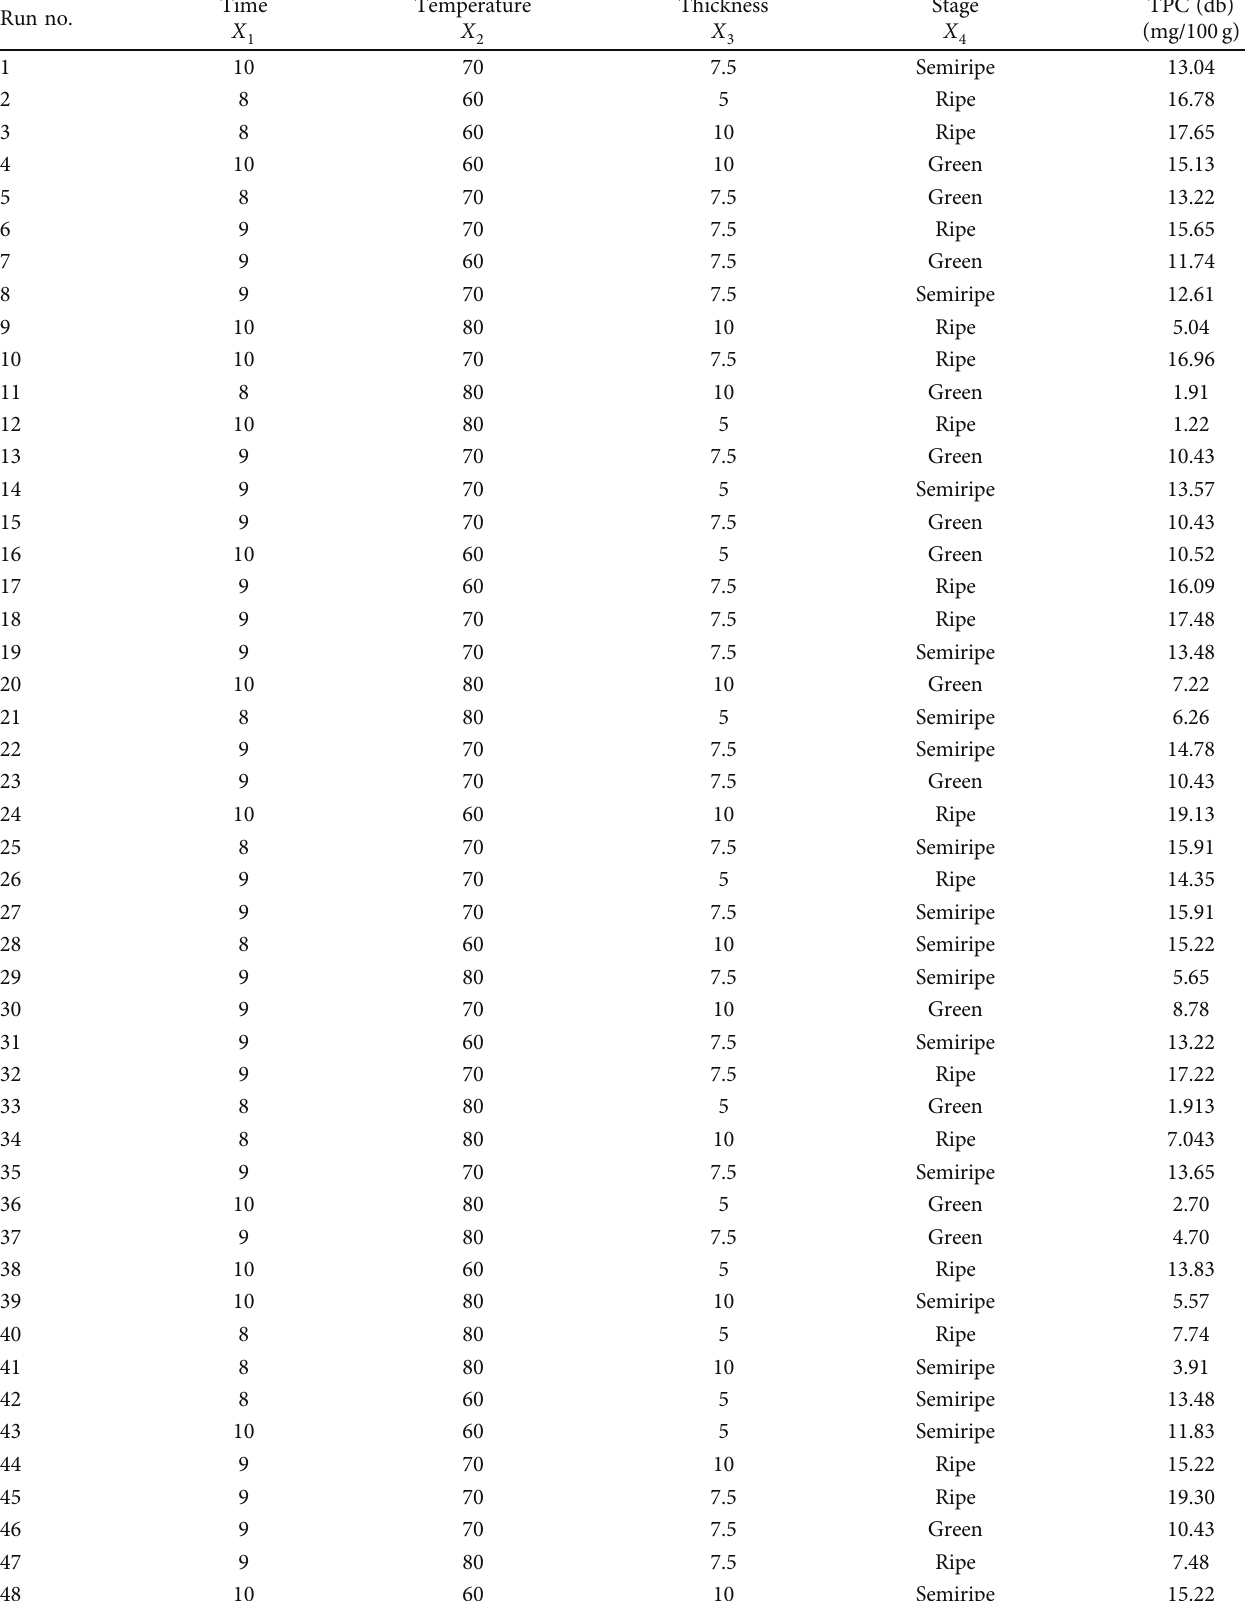
Table 2: Central composite design and results for the response variable (TPC) following the drying process. Run